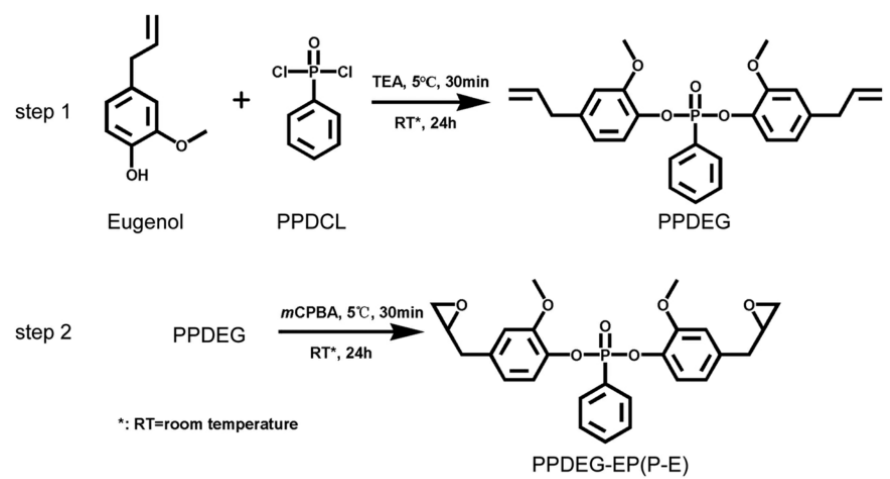
Figure 4. Two-step synthesis route of PPDEG-EP [62].